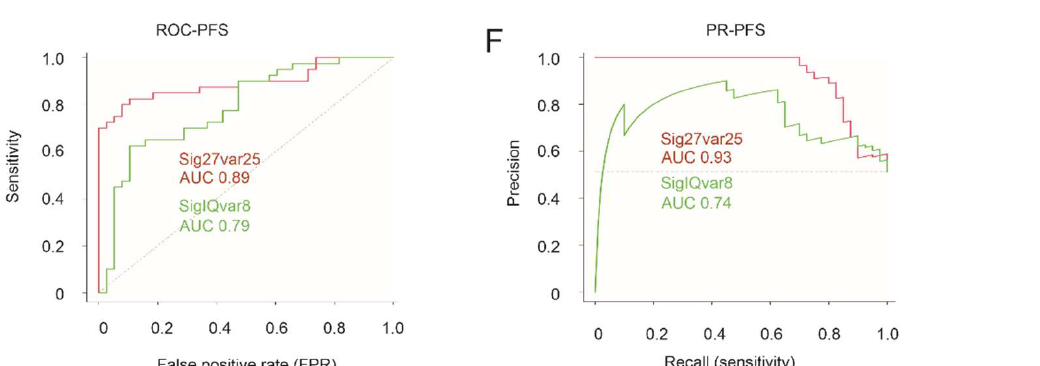
Figure 2. Estimation of ACC progression by Sig27var25 and SigIQvar8. ( A , B ) Waterfall plots for Sig27var25 ( A ) and SigIQvar8 in stratification of ACC progression risk. The progression status, sensitivity, and specificity of the risk separation are indicated. Cutoff points were estimated using the empirical methods with n = 1000 bootstraps and used as the baselines for waterfall plot generation using R. ( C , D ) Separation of ACCs with a high risk of progression from those with low risk by the indicated signatures. Methods used in cutpoint estimation, cutpoints and the respective sensitivity and specificity are indicated. ( E , F ) ROC and PR curves for the indicated multigene panels.